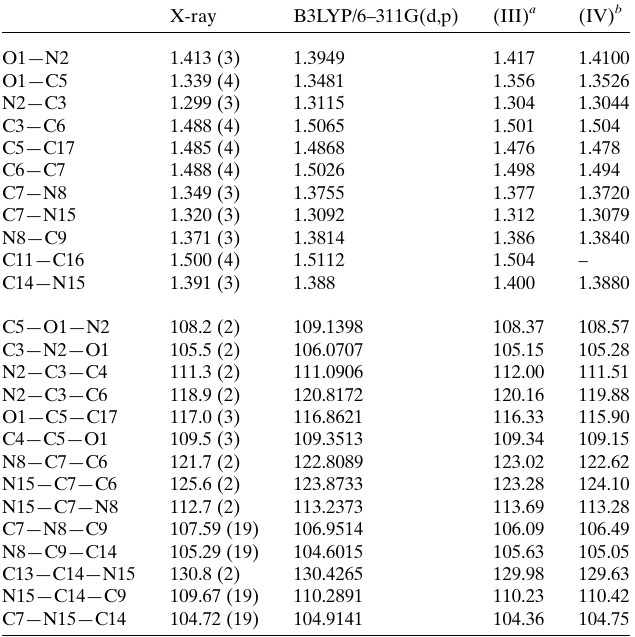
Table 2 Comparison of selected (X-ray and DFT bond lengths and angles (A˚ , (cid:2) ) in the title compound and related structures.